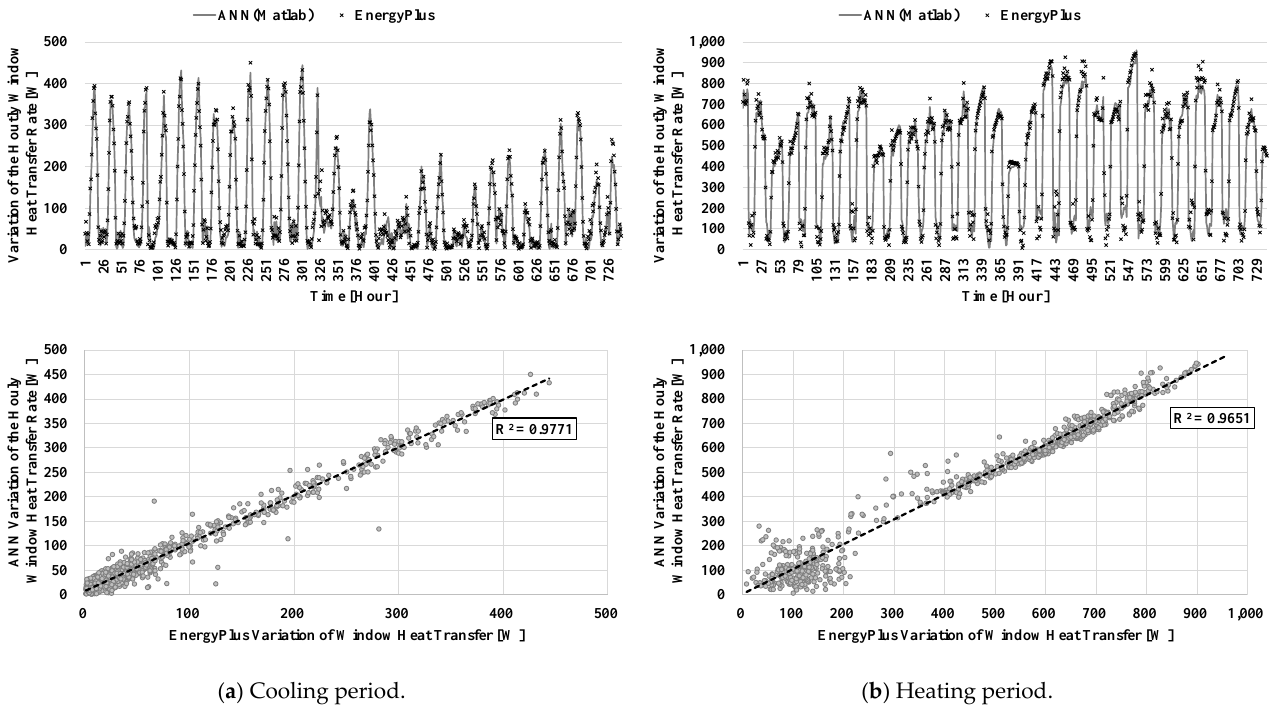
Figure 8. Comparison of window heat transfer in integrated simulation.